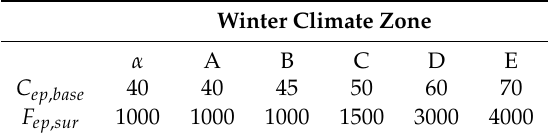
Table 1. Values of the coefficients C ep , base and F ep , sur